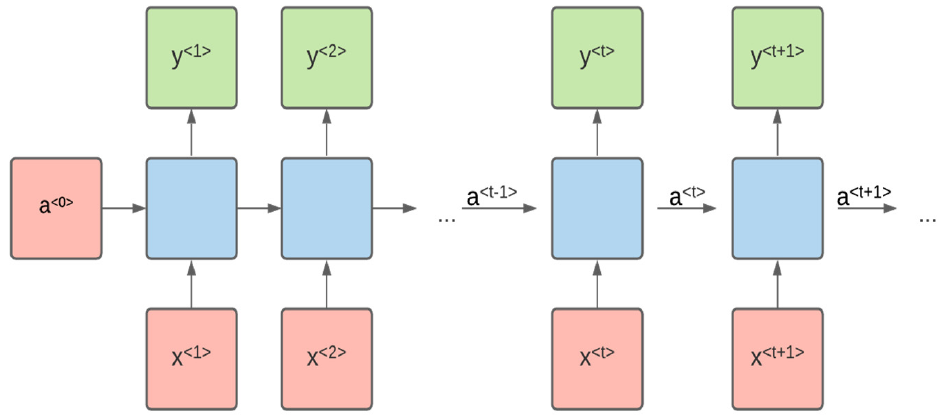
Figure 1. Recurrent softmax.